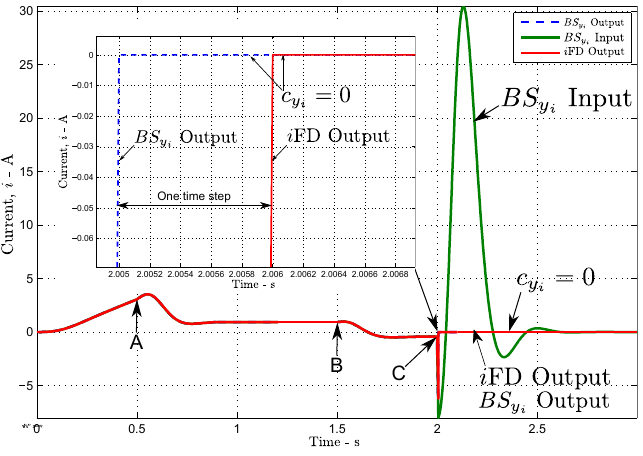
Mult.—Multiplicative, Add.—Additive, FA—False Alarm, Sth.—Stochastic, Dtm.—Deterministic, Bis.—Bias.